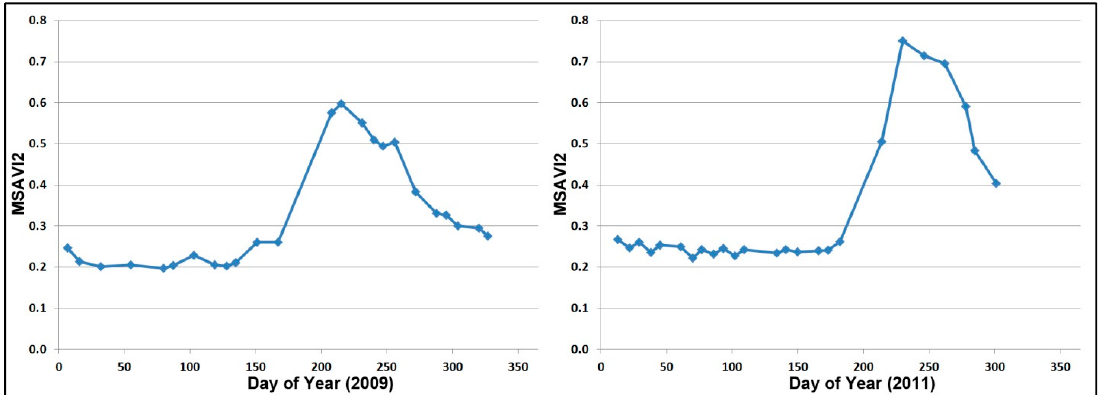
Figure 7. Seasonal patterns of the MSAVI 2 from Landsat 5 for 2009 ( left ) and 2011 ( right ) for an area within Las Cienegas National Conservation Area characterized by predominately dense and continuous grass cover, and selected to represent the reference phenology for calculation of the NDPI.